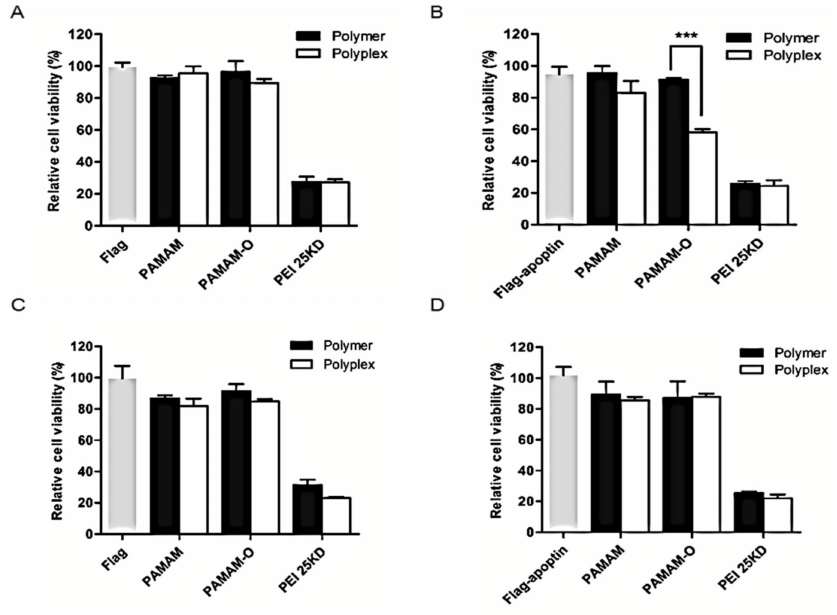
Figure 7. Apoptin-induced apoptosis by the PAMAM-O dendrimer. ( A , B ) Effect on cell viability by PAMAM-O/Flag or 1 µ g of Flag-apoptin. HepG2 cells were transfected with polyplexes of PAMAM and PAMAM-O dendrimers and Flag or Flag-apoptin. After 48 h, cell viability was analyzed using the WST assay. Data represent the mean ± standard deviation ( n = 3). Asterisks show statistical significance. Unpaired t -test: *** p < 0.001; ( C , D ) Dermal fibroblasts were transfected at the same conditions as in panels A and B. After 48 h, cell viability was analyzed using the WST assay. Data represent mean ± standard deviation ( n =